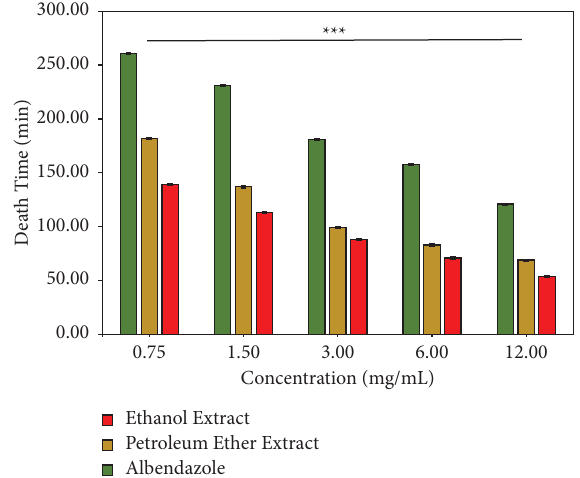
Figure 6: Anthelmintic activity of the extracts of C. nioroense and albendazole (for death)